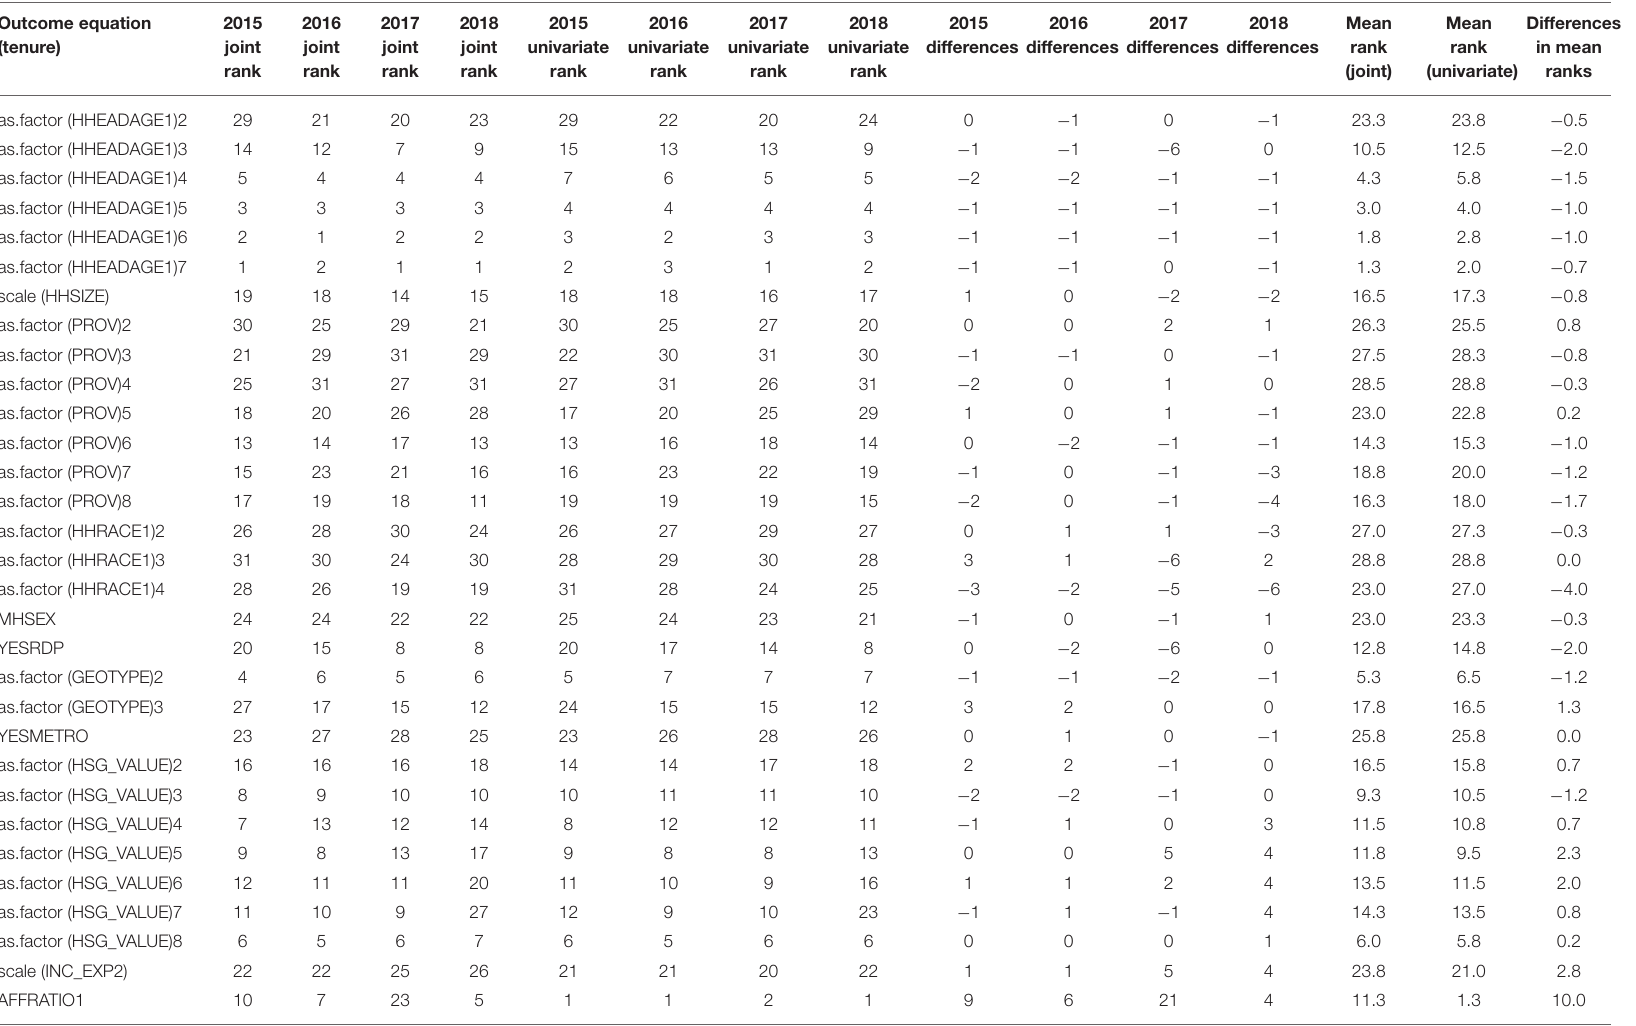
TABLE 5 | Rankings for relative influence (severity) of the